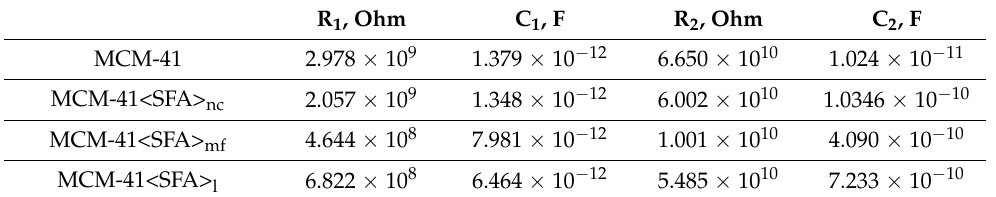
Table 1. Parameters of an equivalent electric circuit for MCM-41 matrix and MCM-41<SFA>